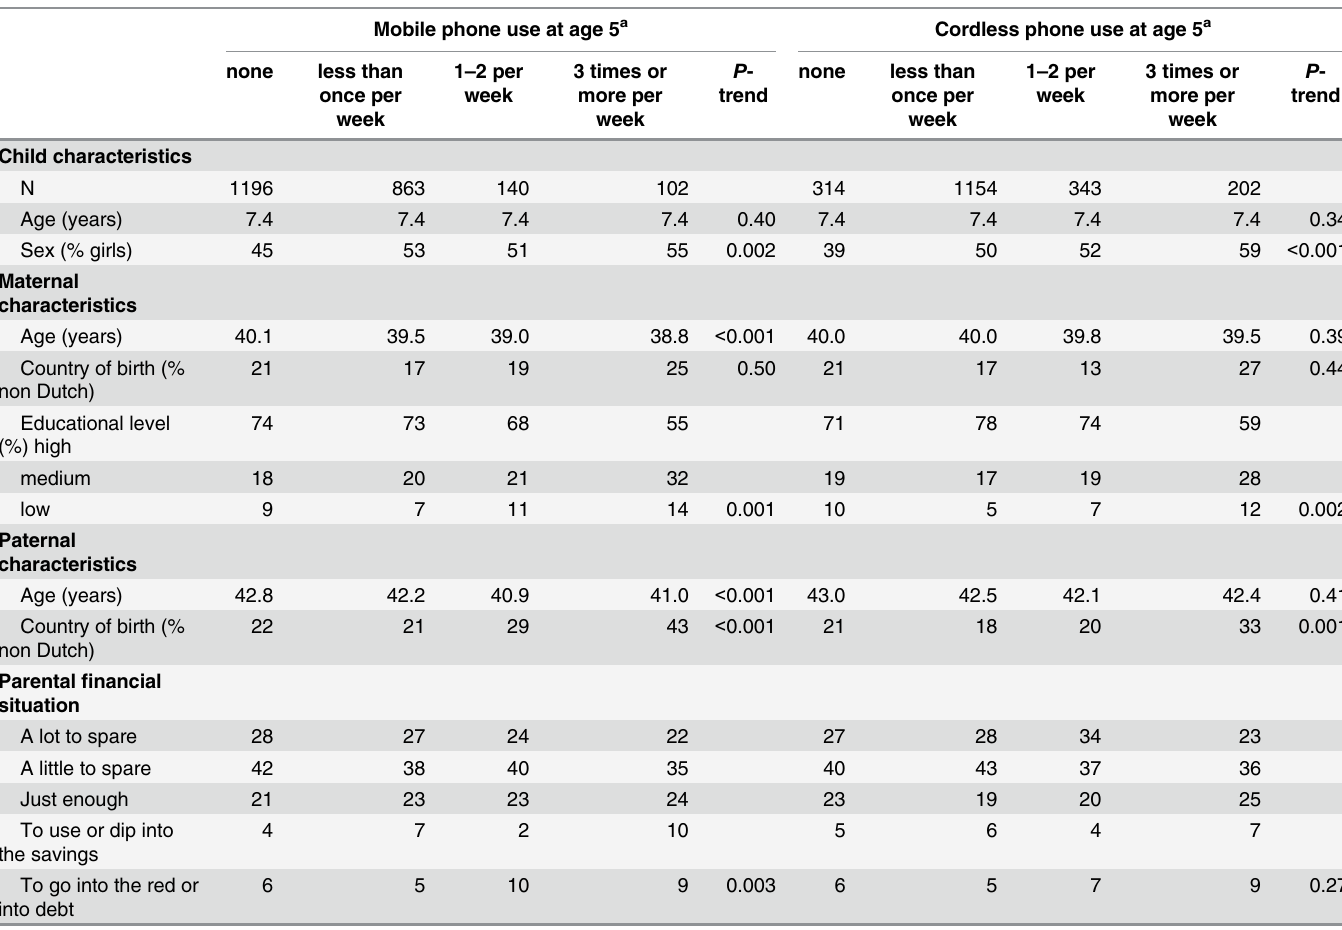
Table 2. Maternal, paternal, and child characteristics by mobile and cordless phone use.